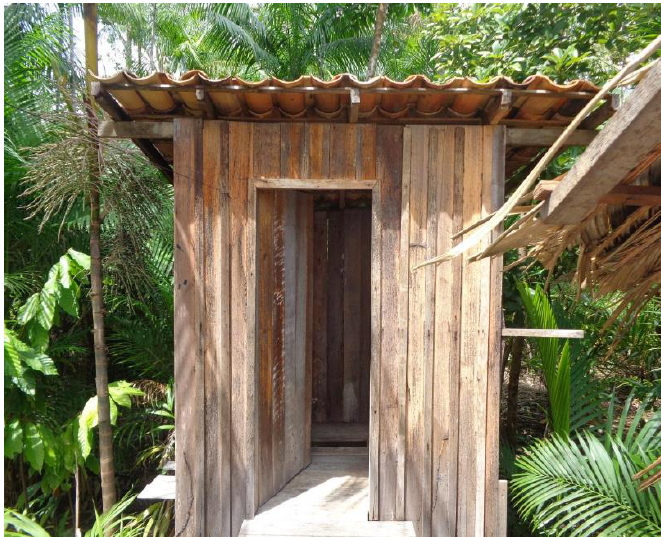
Figura 3: Tipo de banheiro utilizado pelos moradores do PAE. Fonte: IATAM